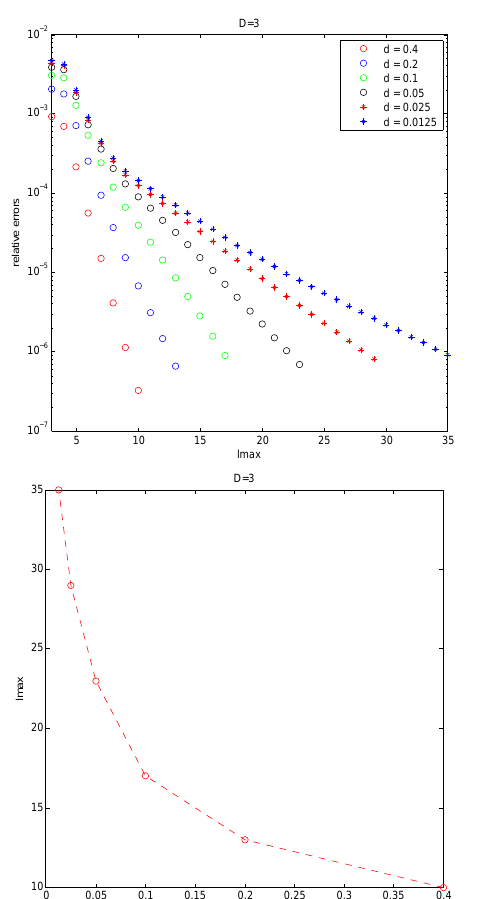
Fig. 4: First: the error Err ( d,D 0 ,L ) with D 0 > δ . Sec- ond: the corresponding L max ( d,D 0 ) as a func- tion of d .